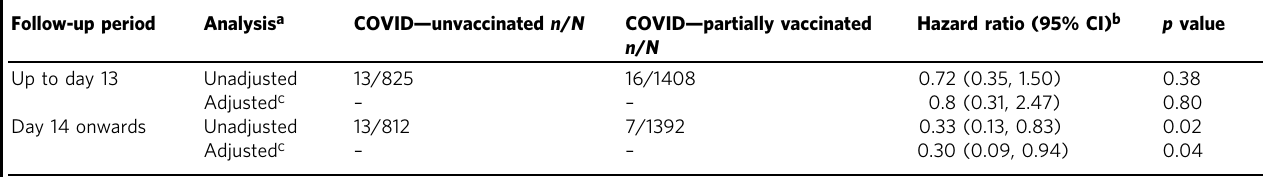
Cox hazard ratios and 95% con fi dence intervals are reported with corresponding p values. p values were estimated by the Wald test. Statistical signi fi cance was set at p <0.05, and two-sided p values were used. a 1 HCW vaccinated and 1 unvaccinated HCW tested positive and within 90 days of vaccination were excluded from the analyses. b Expressed as hazard of COVID-19 in partially vaccinated group relative to unvaccinated group. c Analyses were adjusted for age, sex, staff group, ethnicity and underlying COVID-19